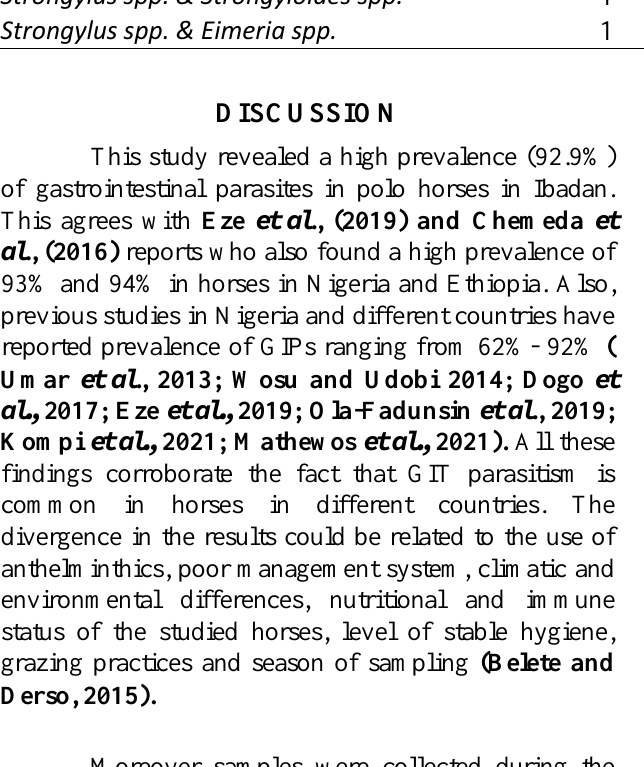
Table 4: Prevalence of gastrointestinal parasites in infected polo horses. Parasites Frequency Percentage (%) Strongylus spp. Strongyloides